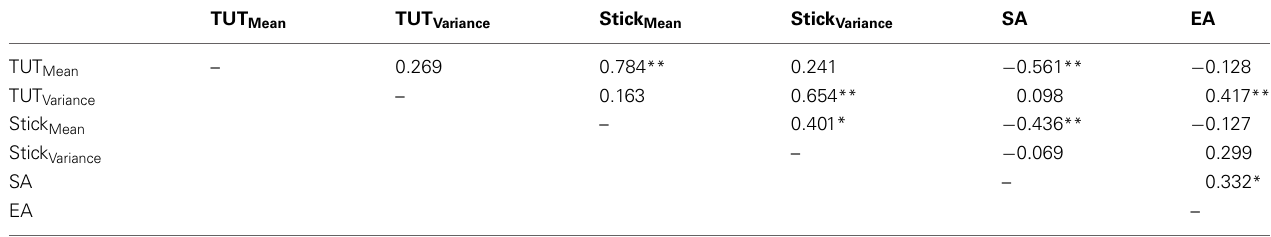
Table 1 | Correlations among study variables.